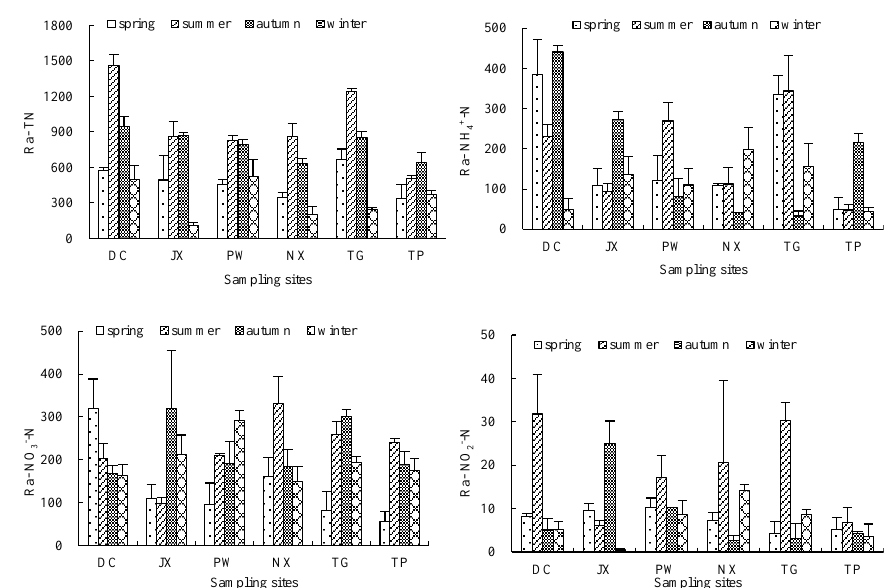
Figure 8. TN, NH 4+ -N, NO 3− -N and NO 2− -N reduction rates in the sampled rivers in different seasons (mg·(m 3 ·d) −1 ).